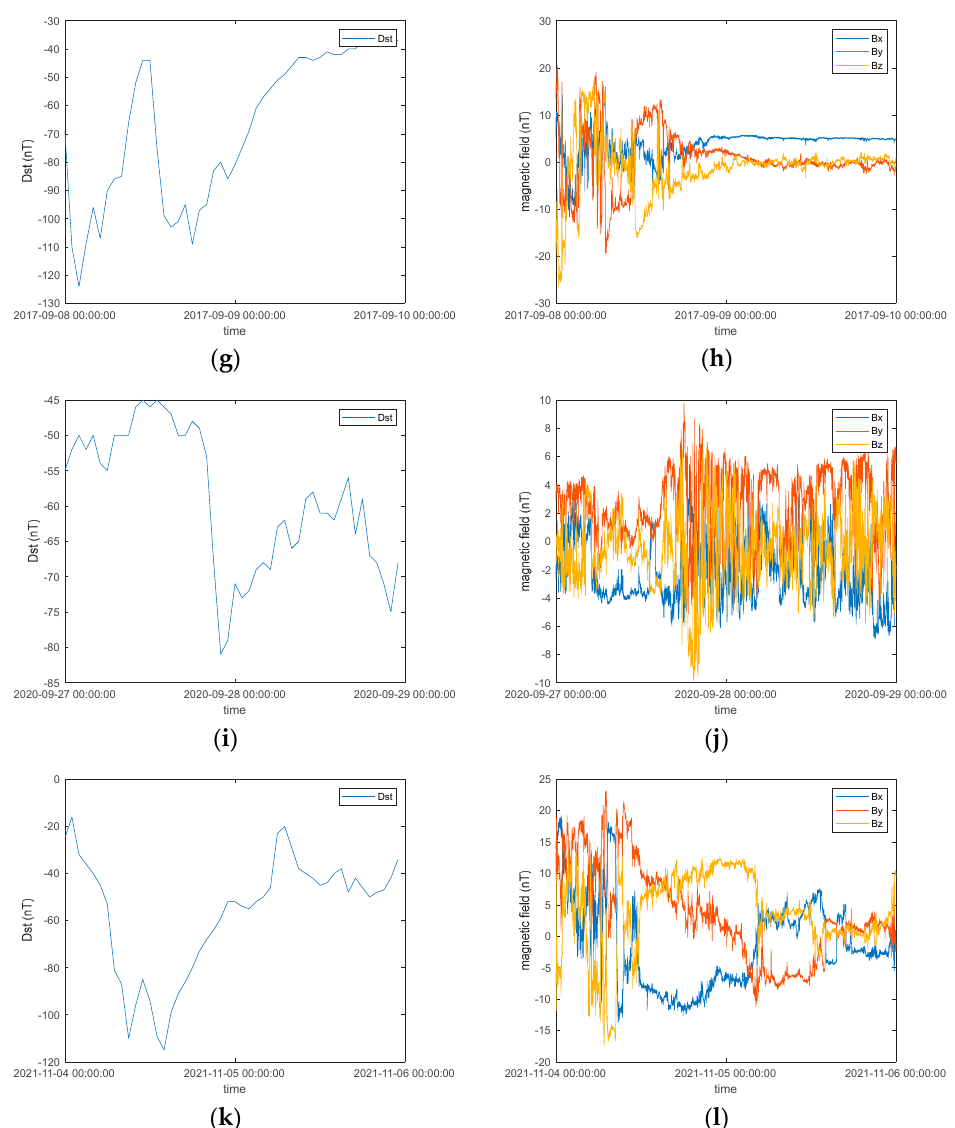
Figure 1. Time-domain plot for Dst and components of the magnetic field. ( a ) Dst from 0:00 on 6 March 2016, to 23:00 on 7 March 2016; ( b ) Components of the magnetic field from 0:00 on 6 March